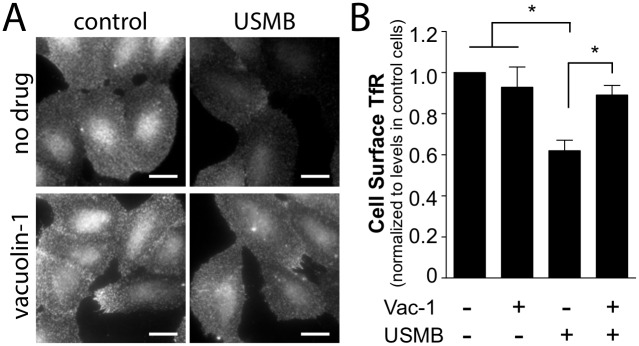
Vacuolin-1 treatment impairs the reduction in cell surface TfR levels by USMB treatment.RPE cells grown on glass coverslips were treated with 5.0 μM vacuolin-1 for 60 min, or not treated with this inhibitor (vehicle control). Cells were subsequently treated with USMB or left untreated (control) as indicated. 5 min after USMB treatment, cells were placed on ice to arrest membrane traffic and subjected to immunofluorescence staining to detect cell surface TfR levels. Shown in (A) are representative epifluorescence micrographs of cell surface TfR levels and in (B) the mean ± SEM of cell surface TfR fluorescence intensity in each condition (n = 3 independent experiments, each experiment >20 cells per condition). Scale = 20 μm. *, p < 0.05.